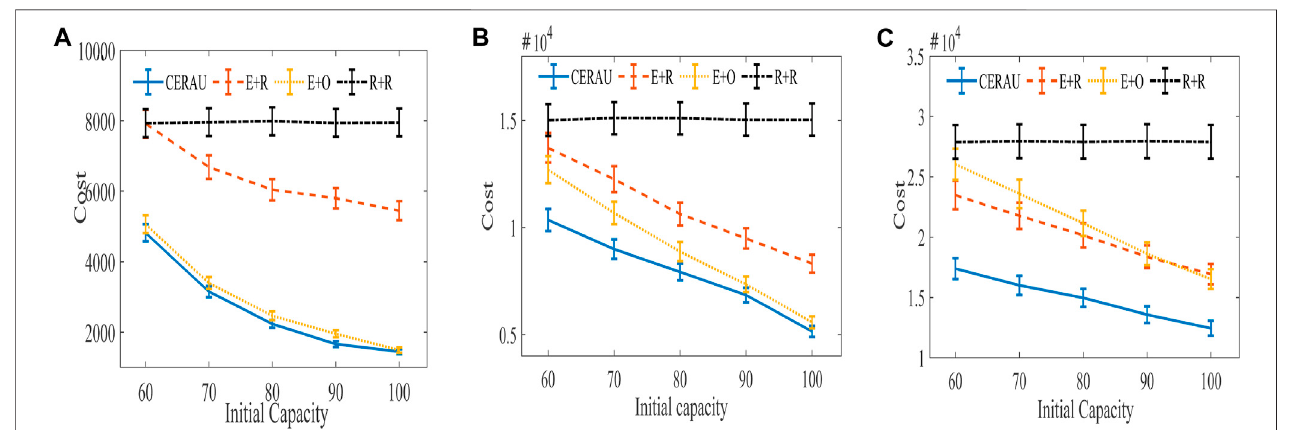
FIGURE 10 | Experimental results of the impact of demanding amount on cost with public cloud. (A) Experimental results of low intensity group. (B) Experimental results of medium intensity group. (C) Experimental results of high intensity group.